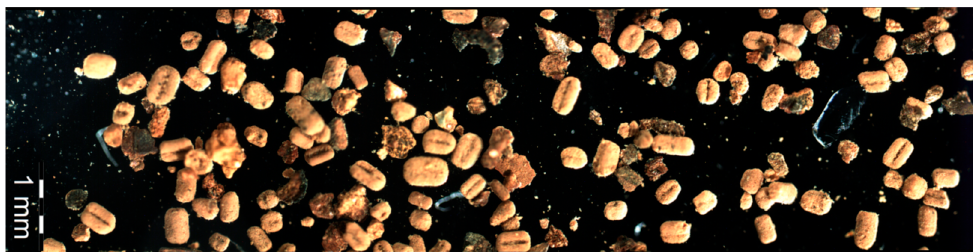
Figure 7. Light microscopy of flushed out drinking water pipe deposits. The deposits are formed by feces pellets of Asellus aquaticus .